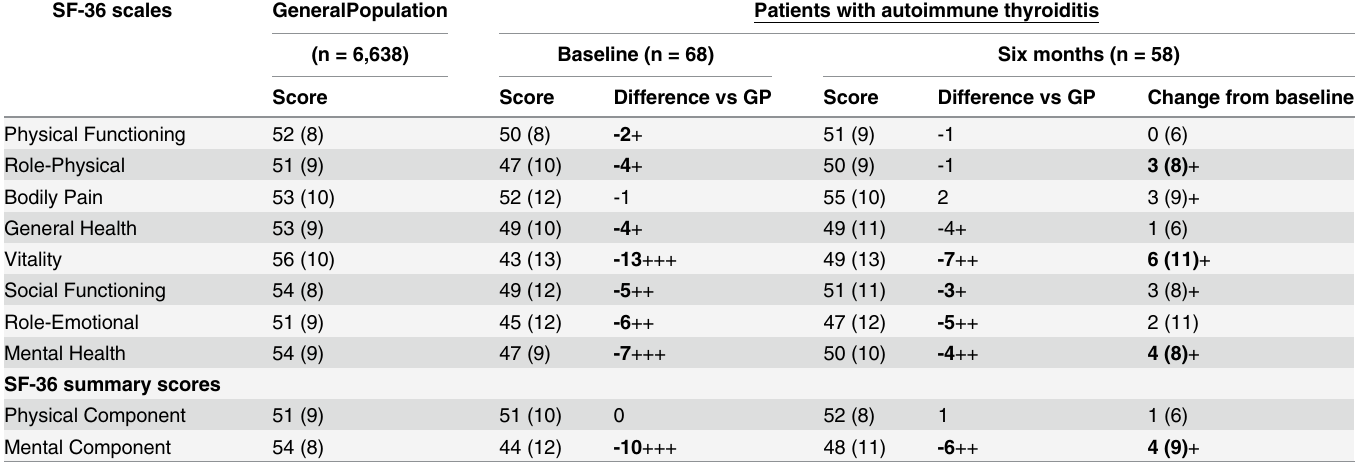
Table 3. SF-36 scale scores.